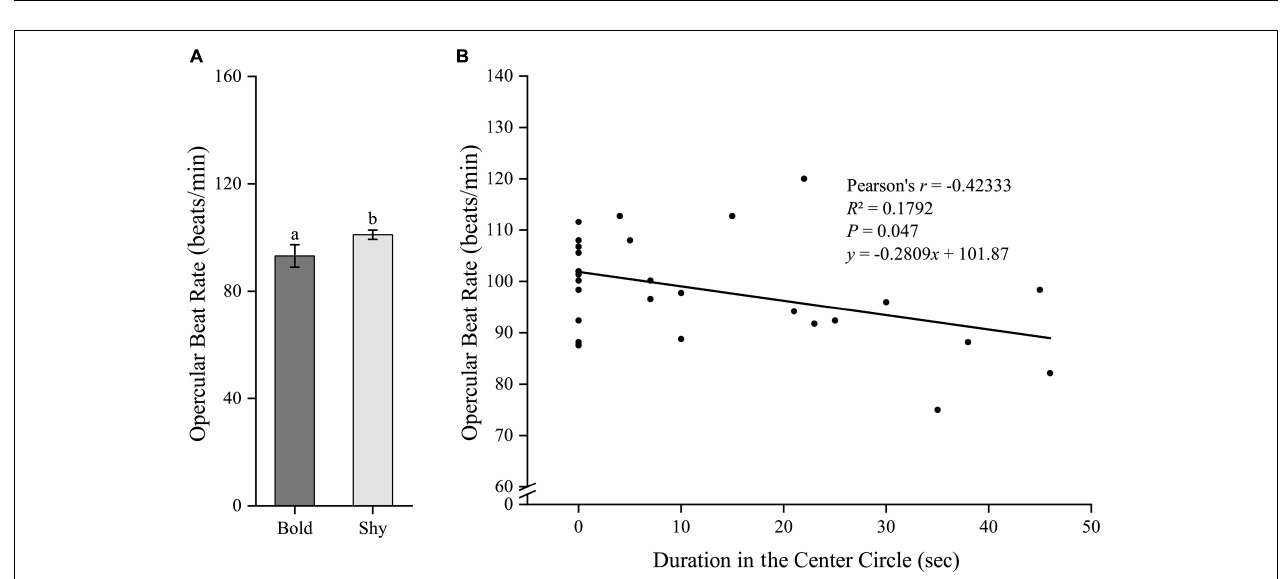
FIGURE 7 | The boldness and stressed opercular beat rate of black rockfish. (A) The stressed opercular beat rate in bold ( n = 9) and shy ( n = 20) groups. Different letters indicate significant differences ( P < 0.05; independent samples t -test). (B) Linear fit of the time duration in center circle (open-field boldness test) and the opercular beat rate (under stressed condition) ( n =